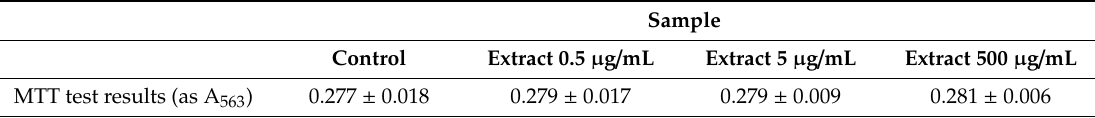
Table 2. 3-(4,5-dimethylthiazol-2-yl)-2,5-diphenyltetrazolium bromide (MTT) cell viability assay results.